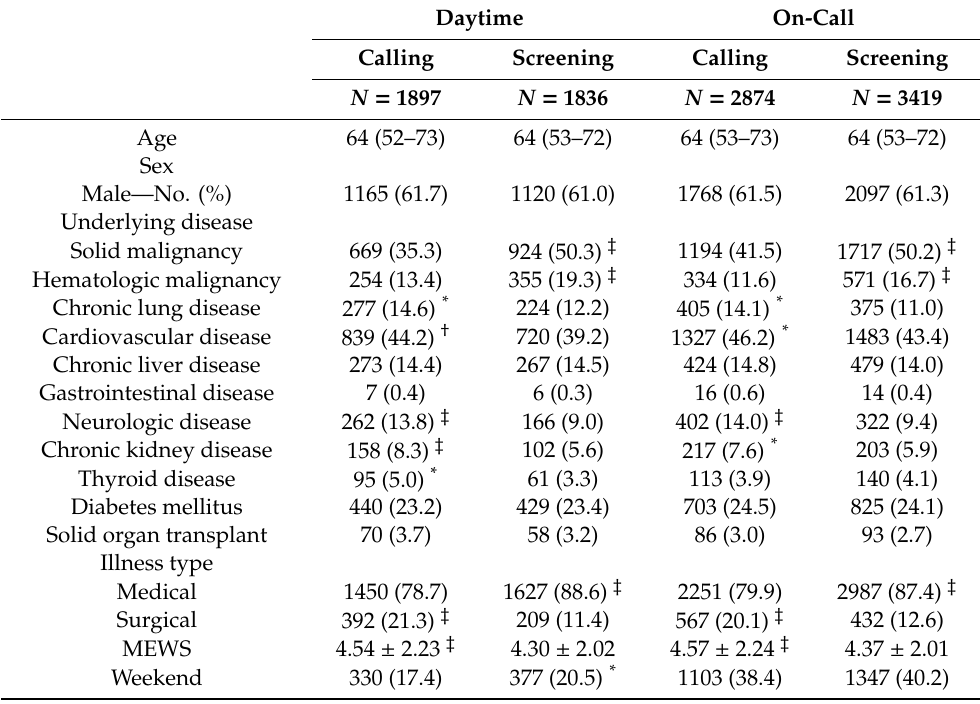
Table 1. Baseline characteristics of included